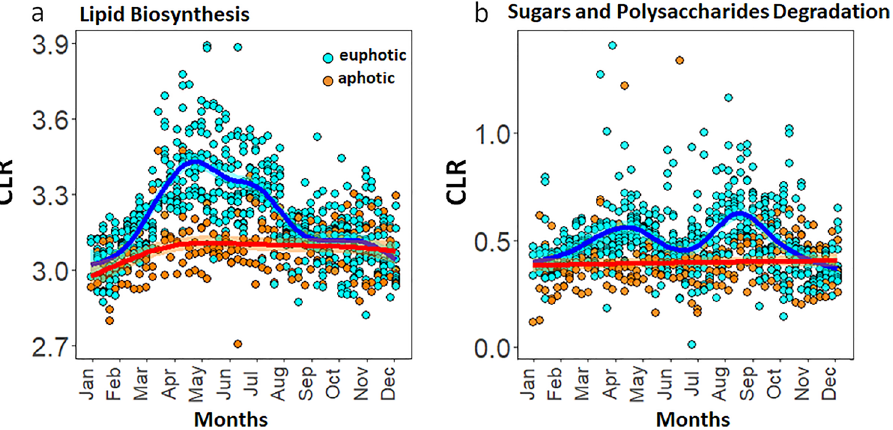
Figure 7. Seasonal trends in lipid biosynthesis pathways (associated with the spring bloom) and Sugars and Polysaccharides degradation (associated with the spring and autumn blooms) in the Bedford basin from 2014 to 2017. Temporal pathways were identified using a permutation test (“multipatt” function from the Indicspecies package 52 ; see “Methods” and Supplementary Table 12). Generalized additive mode smoothings are shown in blue and red ( a,b ).